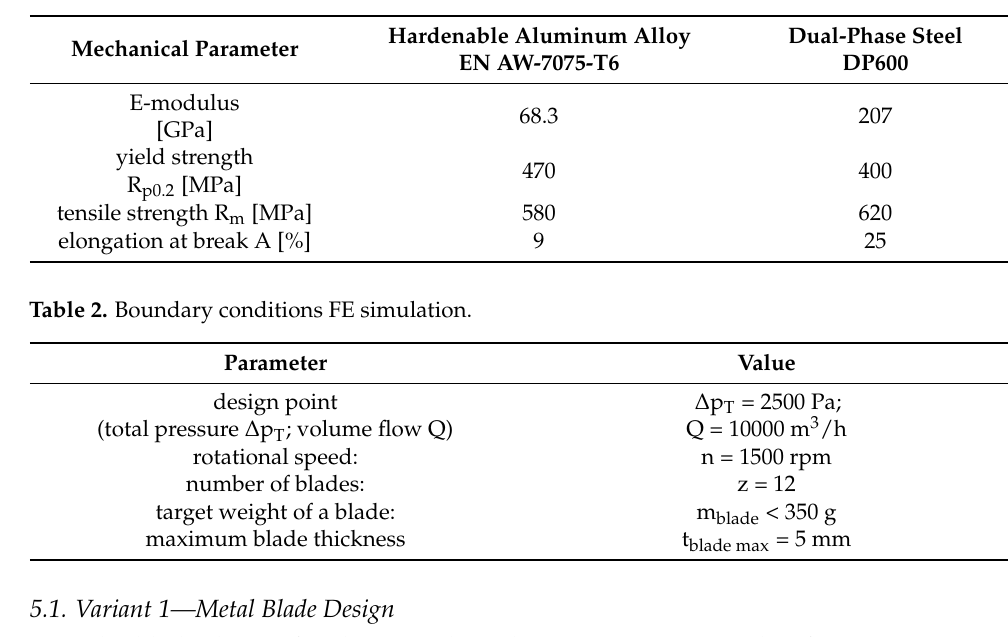
Table 1. Mechanical properties blade material.